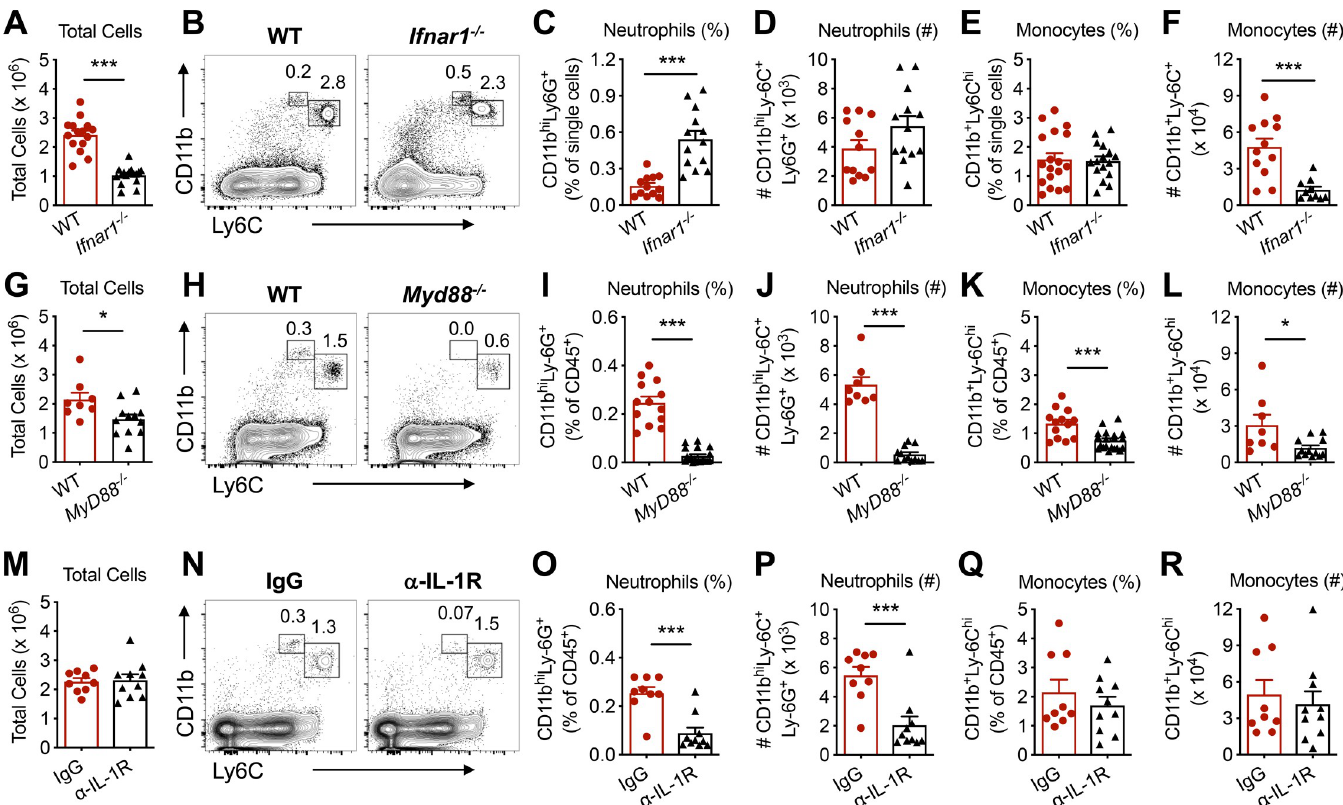
Fig 5. Mechanisms of pathogenic CHIKV-induced myeloid cell recruitment to the dLN. Mice were inoculated with 10 3 PFU of CHIKV AF15561 in the left footpad. At 24 hpi, total cells, CD11b hi Ly6C + Ly6G + neutrophils, and CD11b + Ly6C hi monocytes in the dLN were enumerated in ( A-F ) WT or Ifnar1 -/- mice, ( G-L ) WT or Myd88 -/- mice, or ( M-R ) WT mice treated with 200 μ g IgG or α -IL-1R Ab at the time of infection. Errors bars represent mean ± SEM. Data are combined from 2–4 independent experiments (n = 7–16 mice per group). Statistical significance was determined by Student’s t-test ( � , P < 0.05; ��� , P <